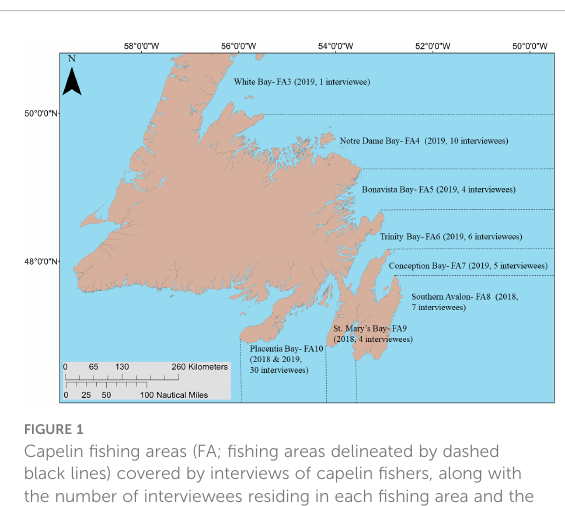
FIGURE 1 Capelin fi shing areas (FA; fi shing areas delineated by dashed black lines) covered by interviews of capelin fi shers, along with the number of interviewees residing in each fi shing area and the year interviews were conducted indicated in